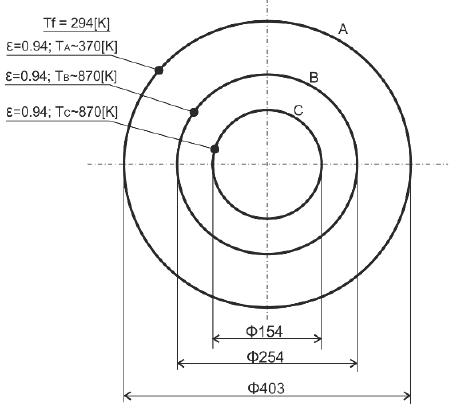
Fig. 2. Simplification sketch of generator turbine geometry